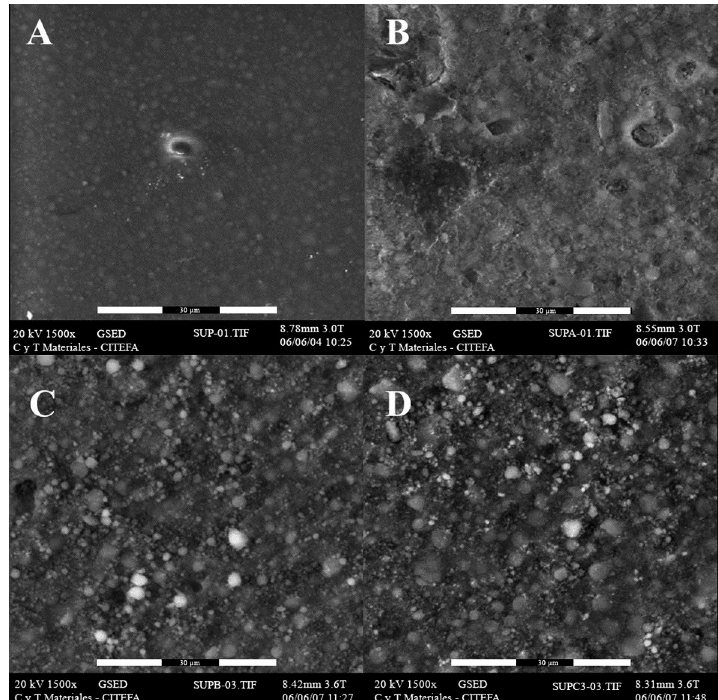
Figure 7- Representative ESEM micrographs of Filtek Supreme at 0 (A), 500 (B), 1000 (C) and 1500 (D) UV accelerated aging hours. Images were taken at 1500x